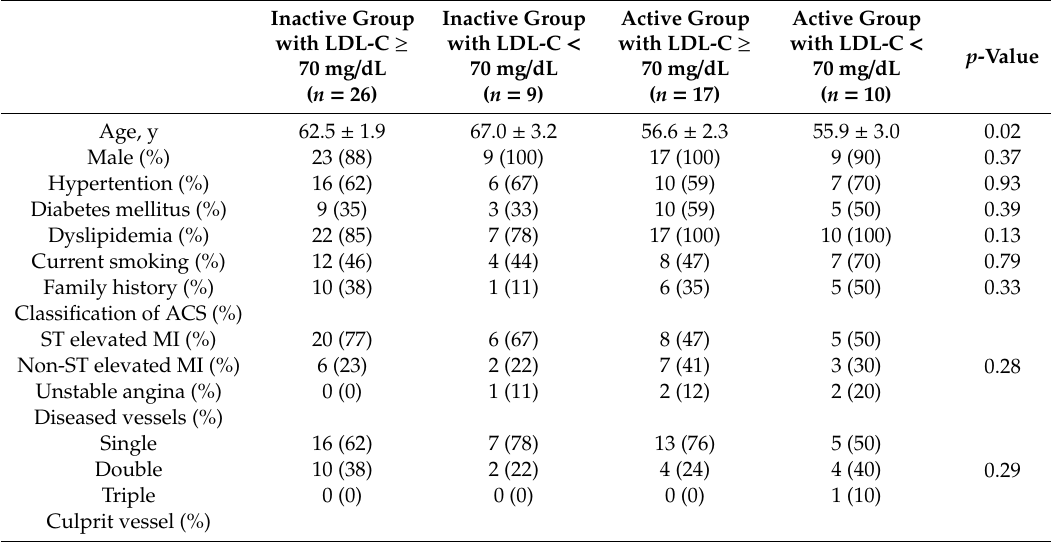
Table 1. Baseline patient